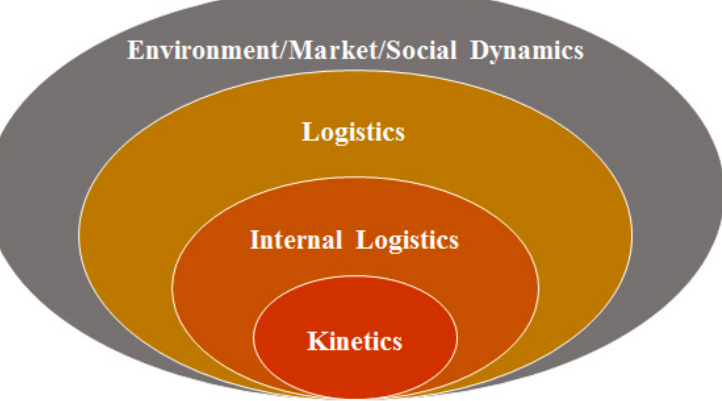
Figure 6. Relationship between smelter kinetics, internal and external smelter logistics, and broader system dynamics.